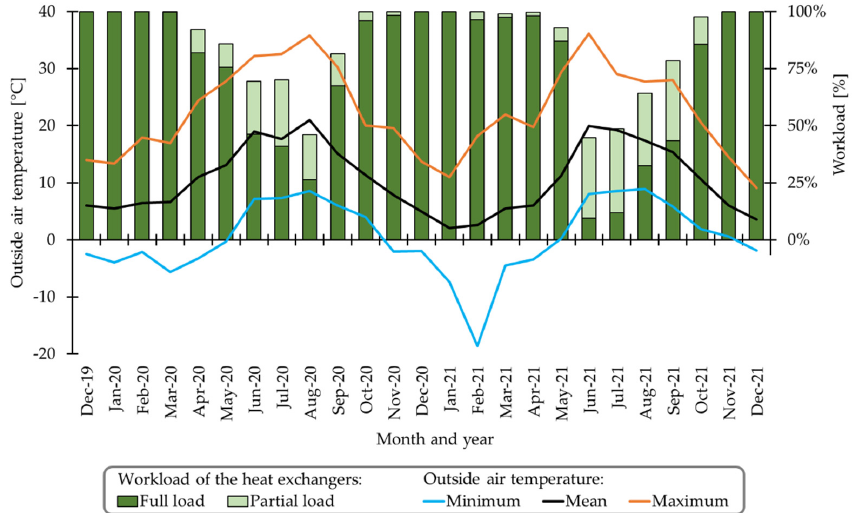
Figure 2. Workload of the heat exchangers (full or partial load) and outside air temperatures t 0 (minimum, maximum, and monthly mean values) on a monthly base over the two-year trial period.